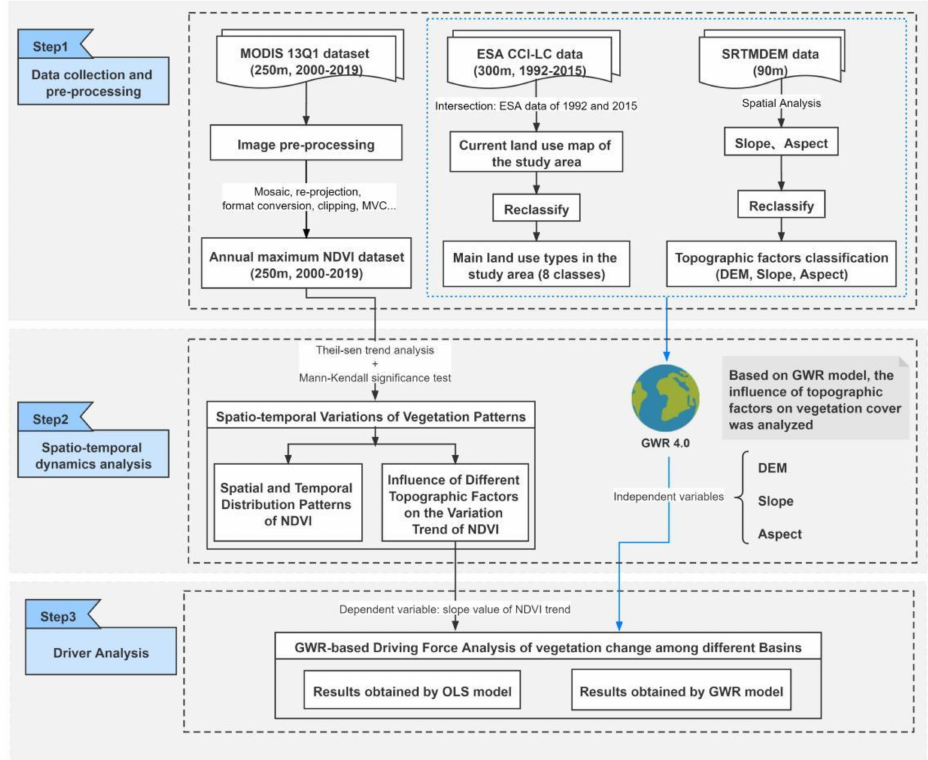
Figure 3. Conceptual framework of study